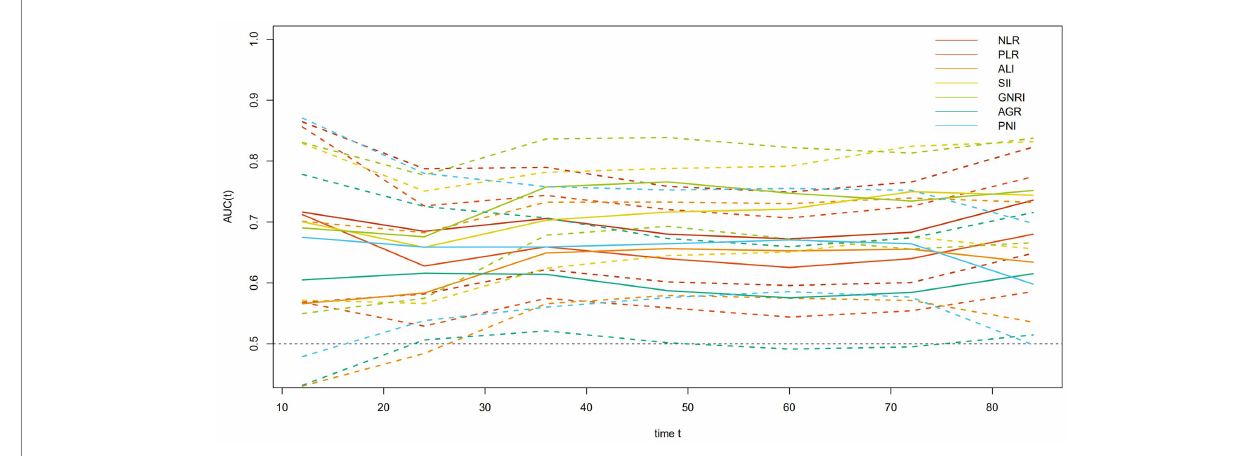
FIGURE 1 Time-dependent ROC for the seven immune-inflammatory